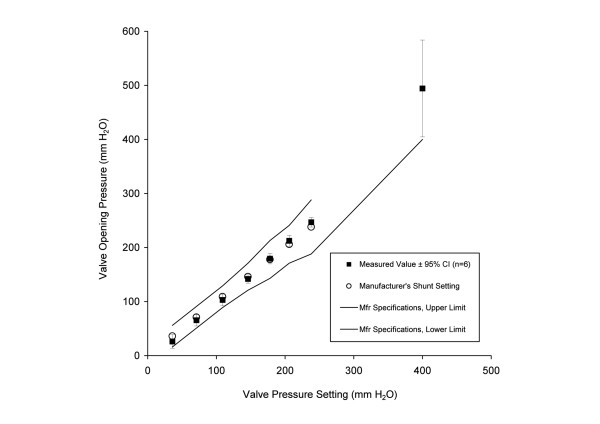
Measured value of shunt opening pressure for the 8 settings (solid black squares) and the manufacturer’s specifications for each shunt setting (open black circles) plotted against the manufacturer’s specification for opening pressure. Error bars show the 95% confidence level based on the six shunts. Tolerance limits for each shunt setting per manufacturer’s specifications are shown as solid lines for comparison. For the highest setting, only the lower limit of opening pressure > 400 mm H2O is specified by the manufacturer; thus, no upper tolerance limit is shown.